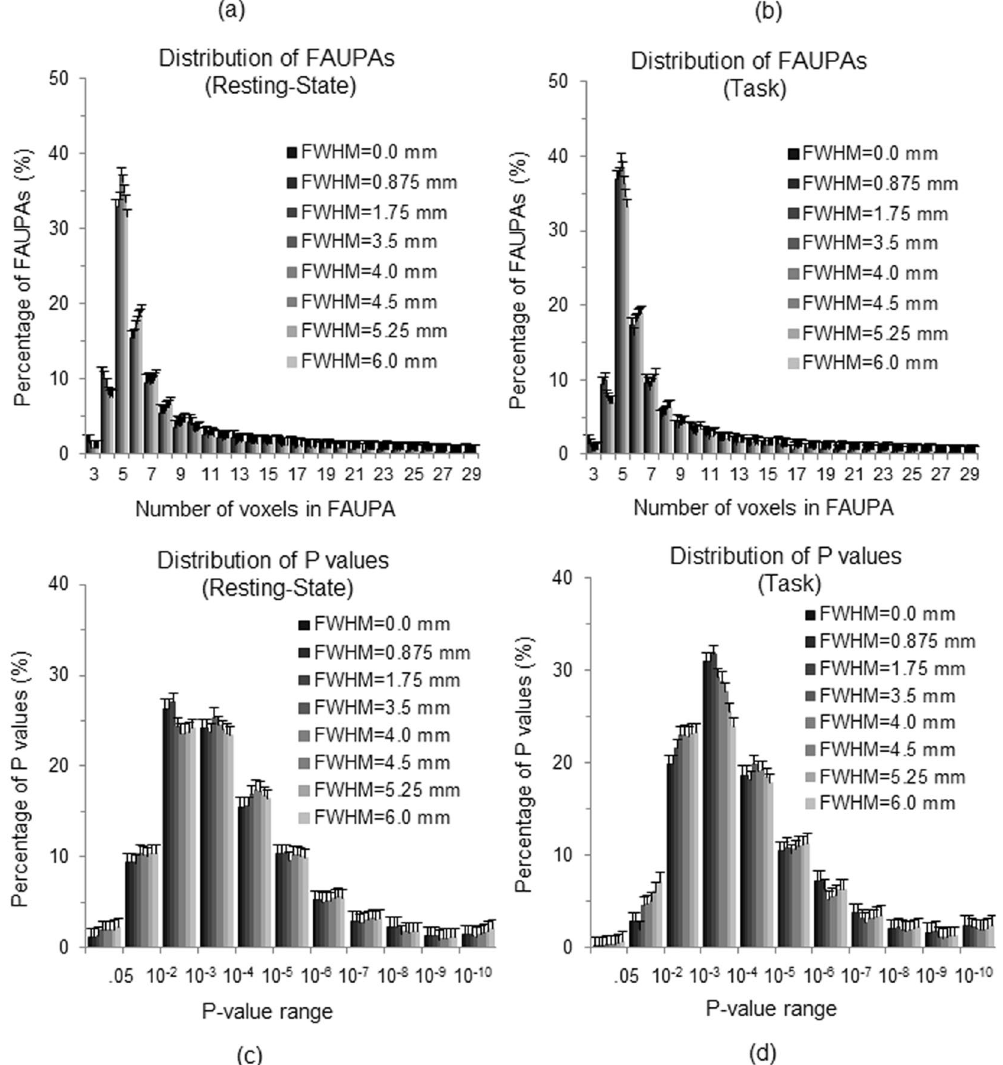
Figure 5. Comparison of the effects of spatial blurring on the histograms for both rs-fMRI and task-fMRI. ( a ) and ( b ): The effects of FWHM on the histogram of group-mean FAUPAs as a function of the total number of voxels contained in a FAUPA; ( c ) and ( d ): The effects of FWHM on the histogram of group-mean P values as a function of P-value range. The error bars indicate the corresponding standard